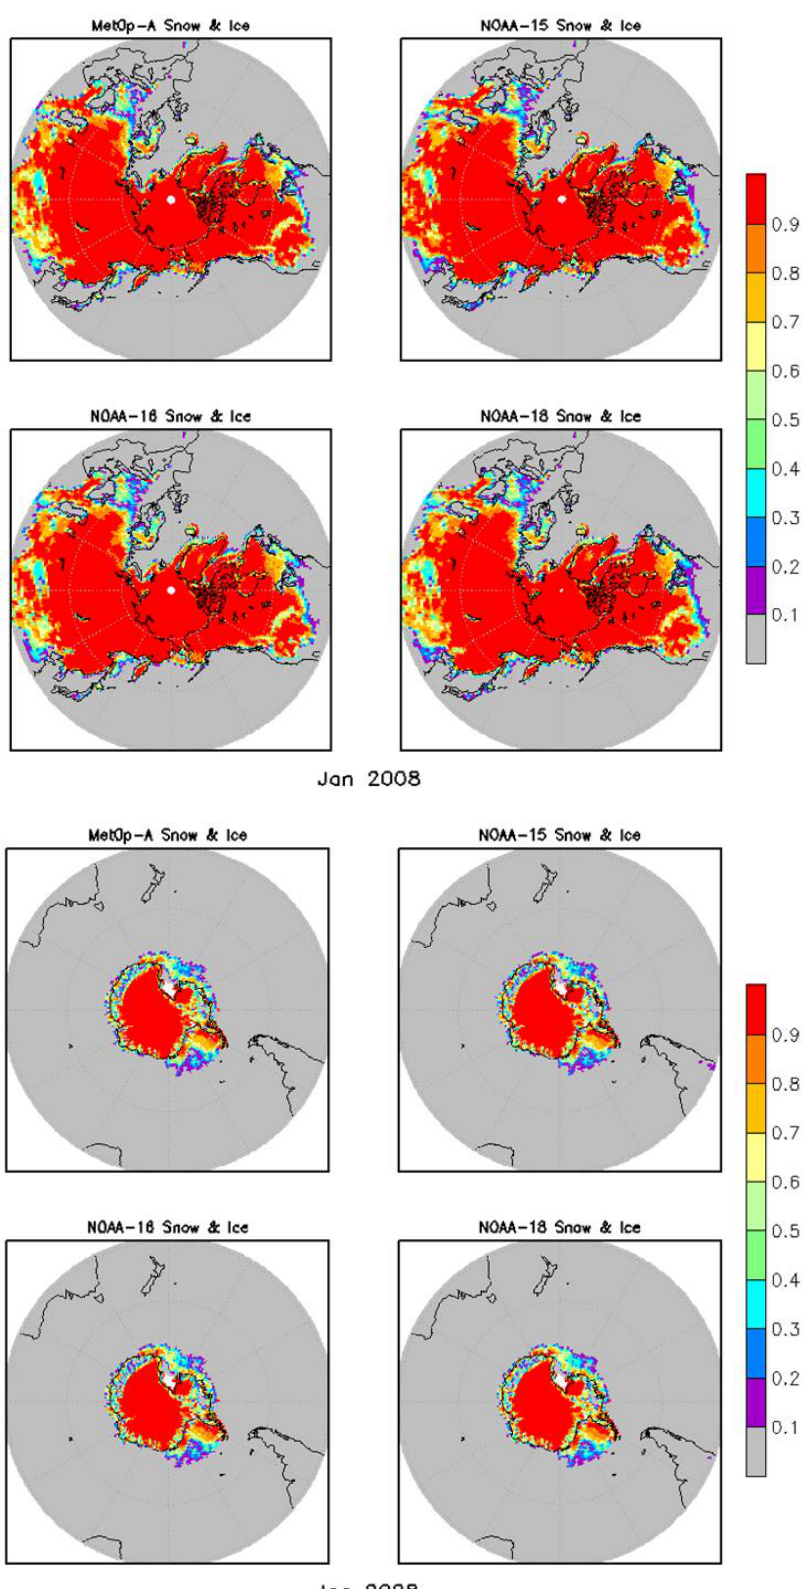
Figure 9. Monthly hemispheric snow cover (fraction of time with snow cover) and sea-ice concentration (monthly mean fractional coverage) for January 2008 for the Northern (upper) and Southern Hemispheres (lower), for N15, N16, N18, and MetOp-A.